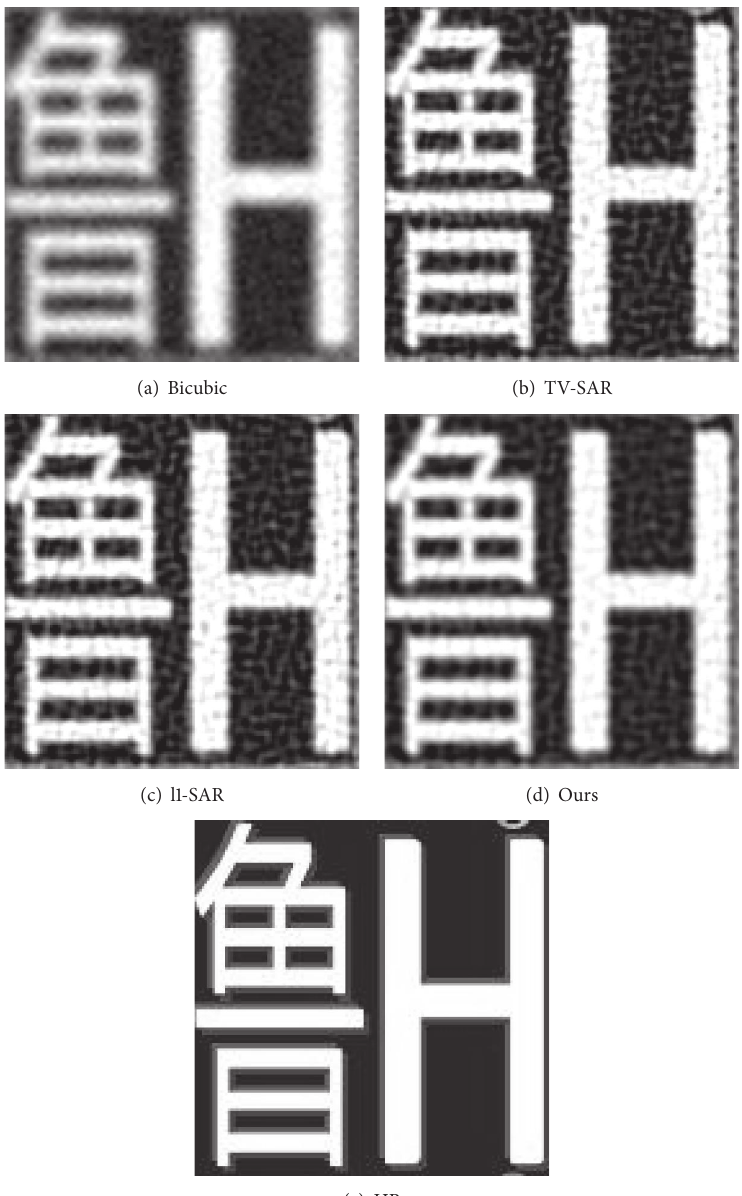
Figure 7: The reconstructed results for Figure 2(c) under white Gaussian noise with 𝜎 = 0.2 .